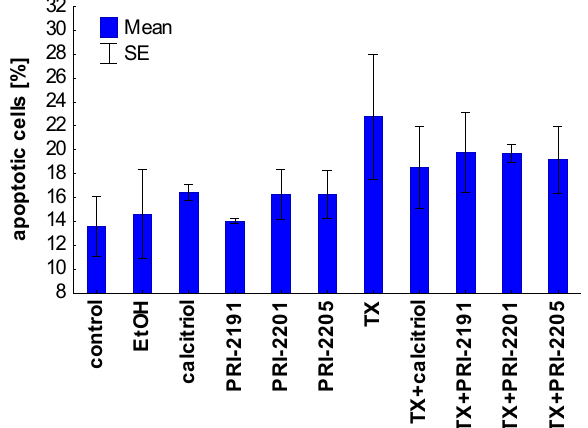
Figure 4. Apoptosis induction by calcitriol or its analogs, alone or used in combination with TX on MCF-7 cells. TX: tamoxifen. The data were displayed as two-color dot plots with FITC-annexin V (FL1-H, Y-axis) vs. PI (FL3-H, X-axis) . Double-negative cells were live cells, PI + /annexin V − necrotic cells, PI weak/annexin V + apoptotic cells, and PI − /annexin V + early apoptotic cells. Data were analysed in WinMDI 2.9 program